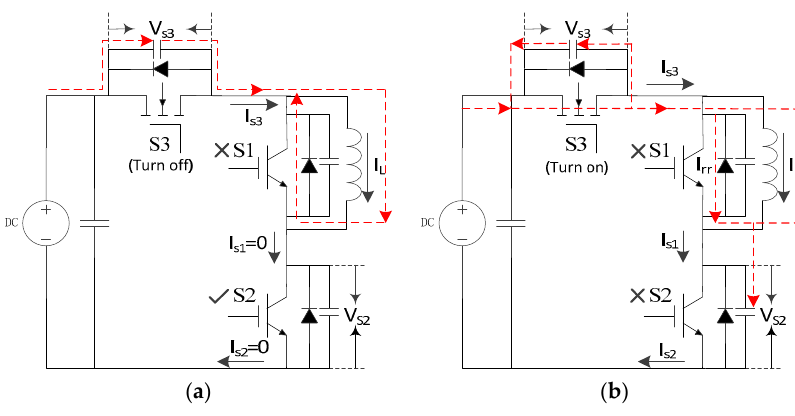
Figure 5. Turn-off period ( a ) Stage 2-at t4; and, ( b ) Stage 6-at t6.